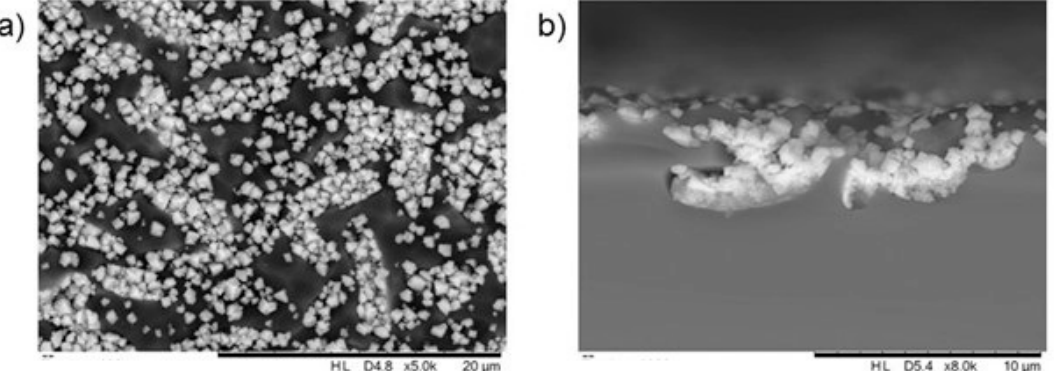
Figure 7. SEM image in ( a ) plane view and ( b ) cross section of silicon wafer with typical pits, acidic texture with perovskite